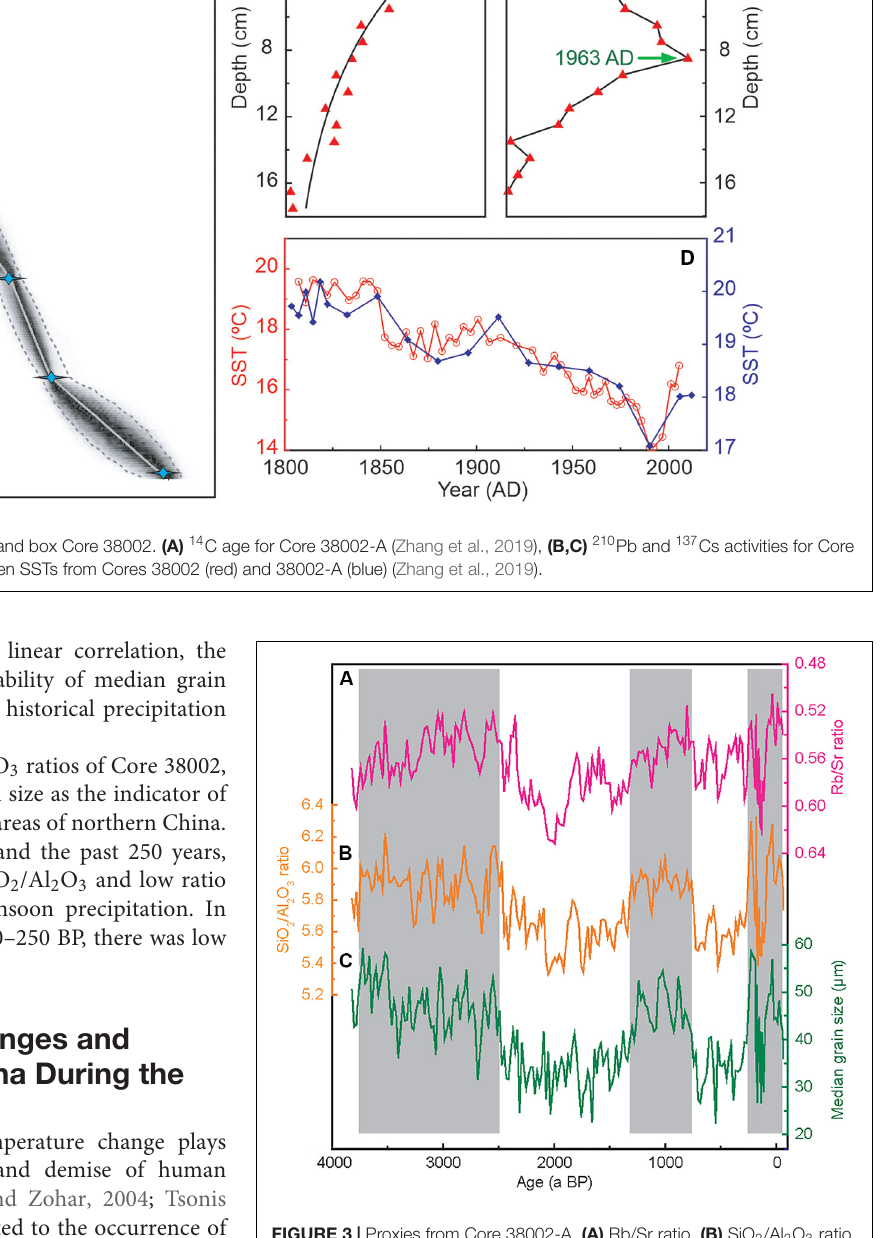
FIGURE 3 | Proxies from Core 38002-A. (A) Rb/Sr ratio, (B) SiO 2 /Al 2 O 3 ratio, (C) Median grain